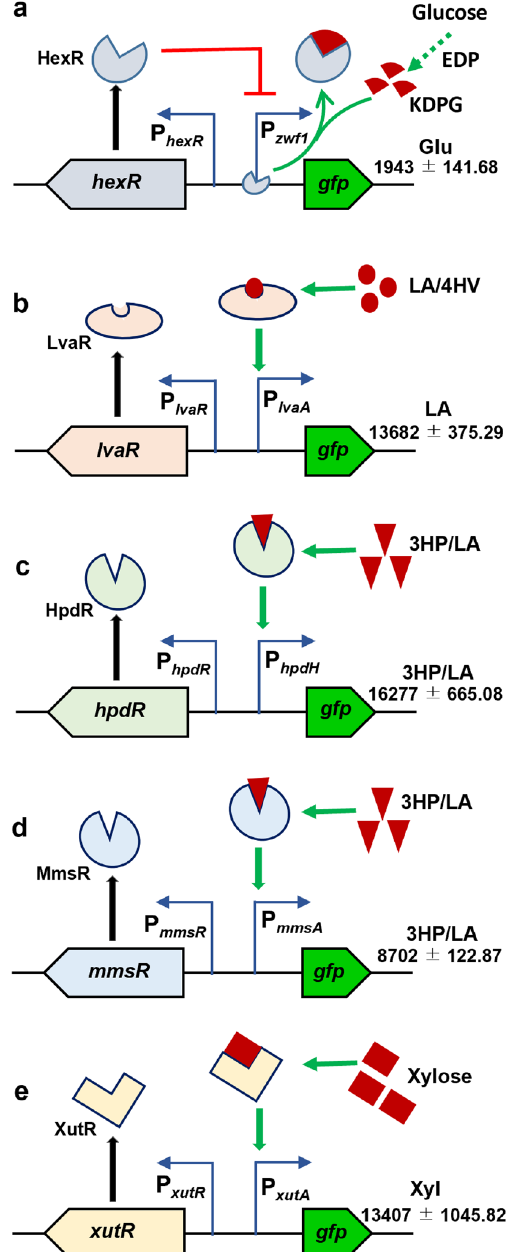
Figure 1. Schematic representations of the activation of the substrate-inducible promoter systems. ( a ) activation of the HexR/P zwf1 system by glucose through the EDP effector molecule KDPG; ( b ) activation of the LvaR/P lvaA system by LA or 4HV; ( c ) activation of the HpdR/P hpdH system by 3HP or LA; ( d ) activation of the MmsR/P mmsA system by 3HP or LA; ( e ) activation of the XutR/P xutA system by xylose. The numerical values (mean ± standard deviation) and the inducer(s) represent the maximum normalized fluorescence intensity of the corresponding system with the respective inducer(s). Both 3HP and LA (3HP/LA) showed the maximum level of expression ( P > 0.05) in ( c ) and ( d ). EDP, Entner–Doudoroff pathway; KDPG, 2-keto-3-deoxy-6- phosphogluconate; gfp , green fluorescent protein; Glu, glucose; LA, levulinic acid; 4HV, 4-hydroxyvalerate; 3HP, 3-hydroxypropionic acid; Xyl,